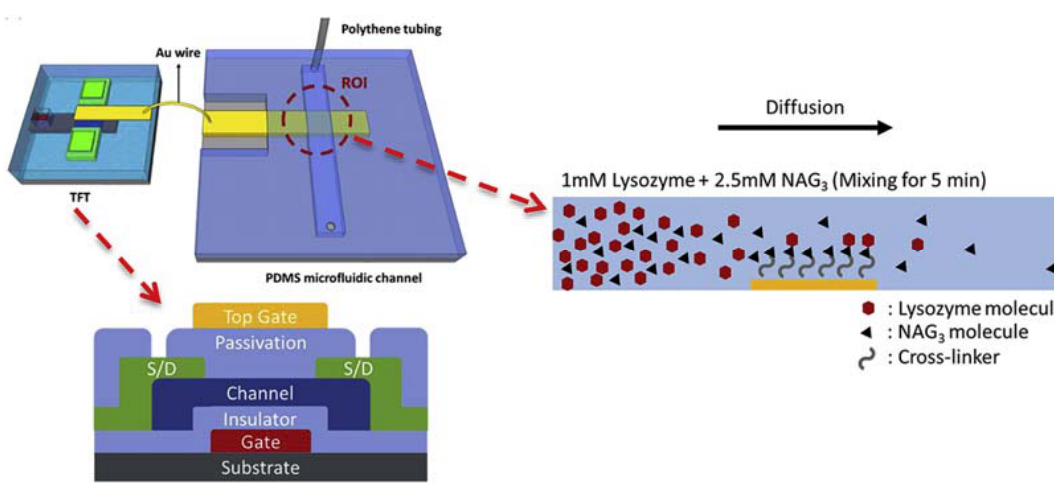
Figure 5. Schematic diagram of the integrated sensor with an extended gate and a representation of the biomolecule interaction. Reprint by permission from Elsevier.